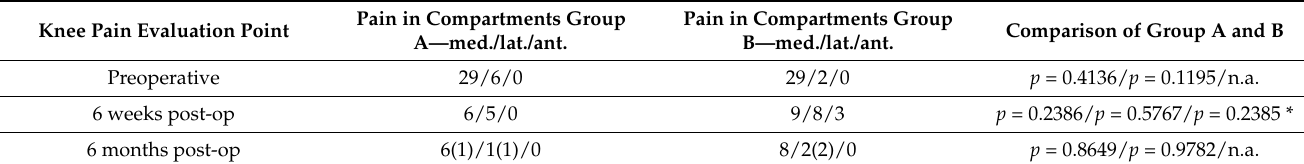
Table 3. Pre- and post-operative incidence of severe pain presence of severely (NRS at least 4) in compartments of examined knee joints. The data regarding painful compartments is given in the following order: medial/lateral/anterior; Number of patients who developed pain in previously asymptomatic compartments was given in brackets. Comparison of both groups presents results of Chi-squared test except for one case marked with asterisk, where Fisher’s exact test was used to verify potential differences for a small group; n.a.—not applicable as there was no anterior knee pain. Pain in Compartments Group Pain in Compartments Group Knee Pain Evaluation Point A—med./lat./ant. B—med./lat./ant.